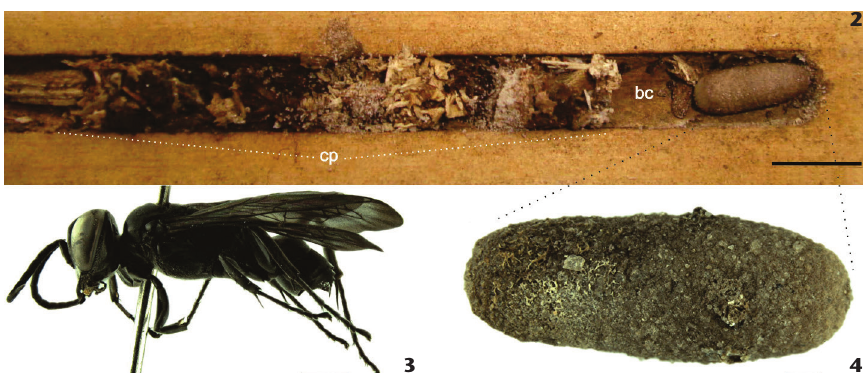
Figures 2-4. (2) 0.7 cm diameter trap-nest showing nest structures: closure plug (cp) and brood cell with cocoon (bc); (3) adult female; (4) cocoon. Scale bars: 2= 10 mm, 3-4 = 1